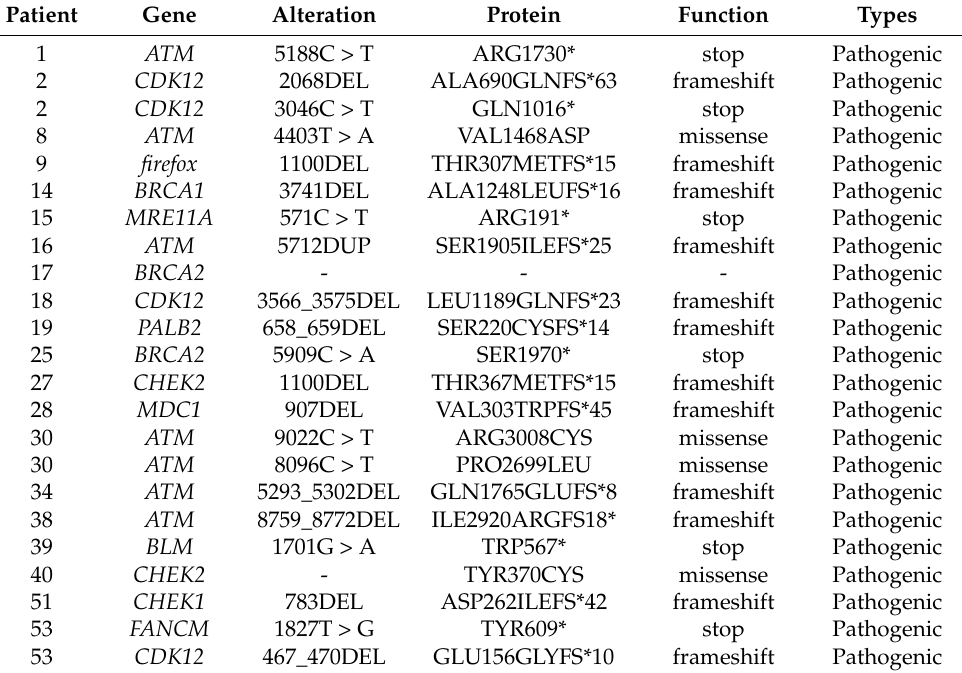
Table 2. Pathogenic or likely pathogenic variants identified on prostatic tumor somatic analysis among mCRPC